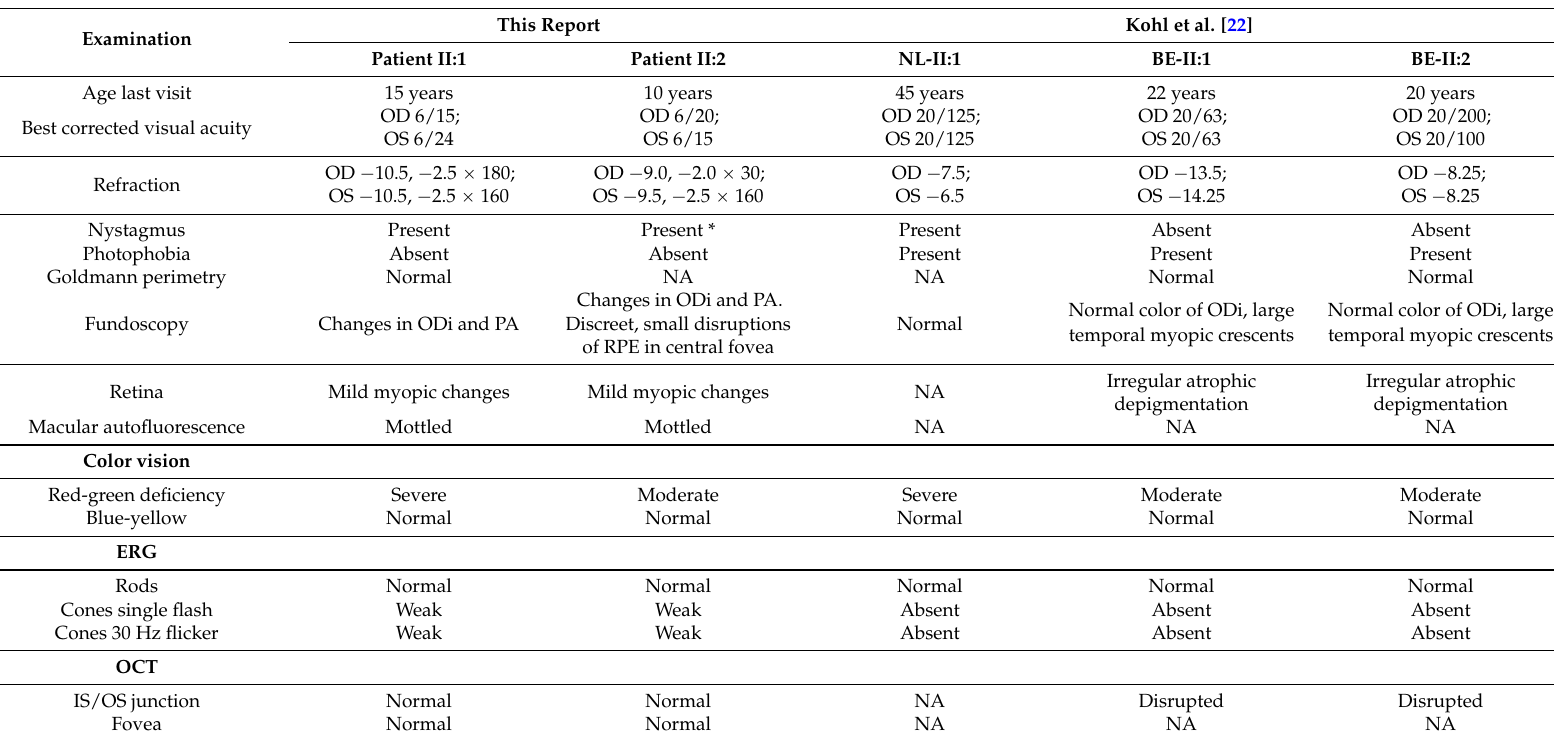
Table 1. Comparison of the ophthalmological presentation of the five patients reported with biallelic c.35C>G variant in PDE6H